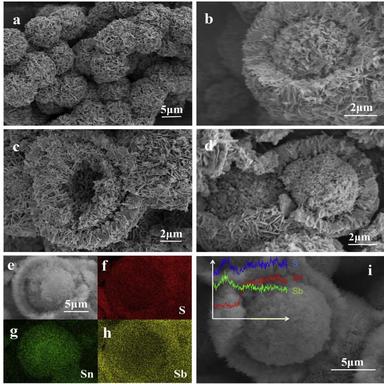
aed) SEM images of yolk-shell Sn-Sb-S microflower composite, e-h) SEM image and the corresponding EDS elemental mapping: sulfur, tin, antimony, i) EDS line-scanning image of yolk-shell Sn-Sb-S microflower composite.